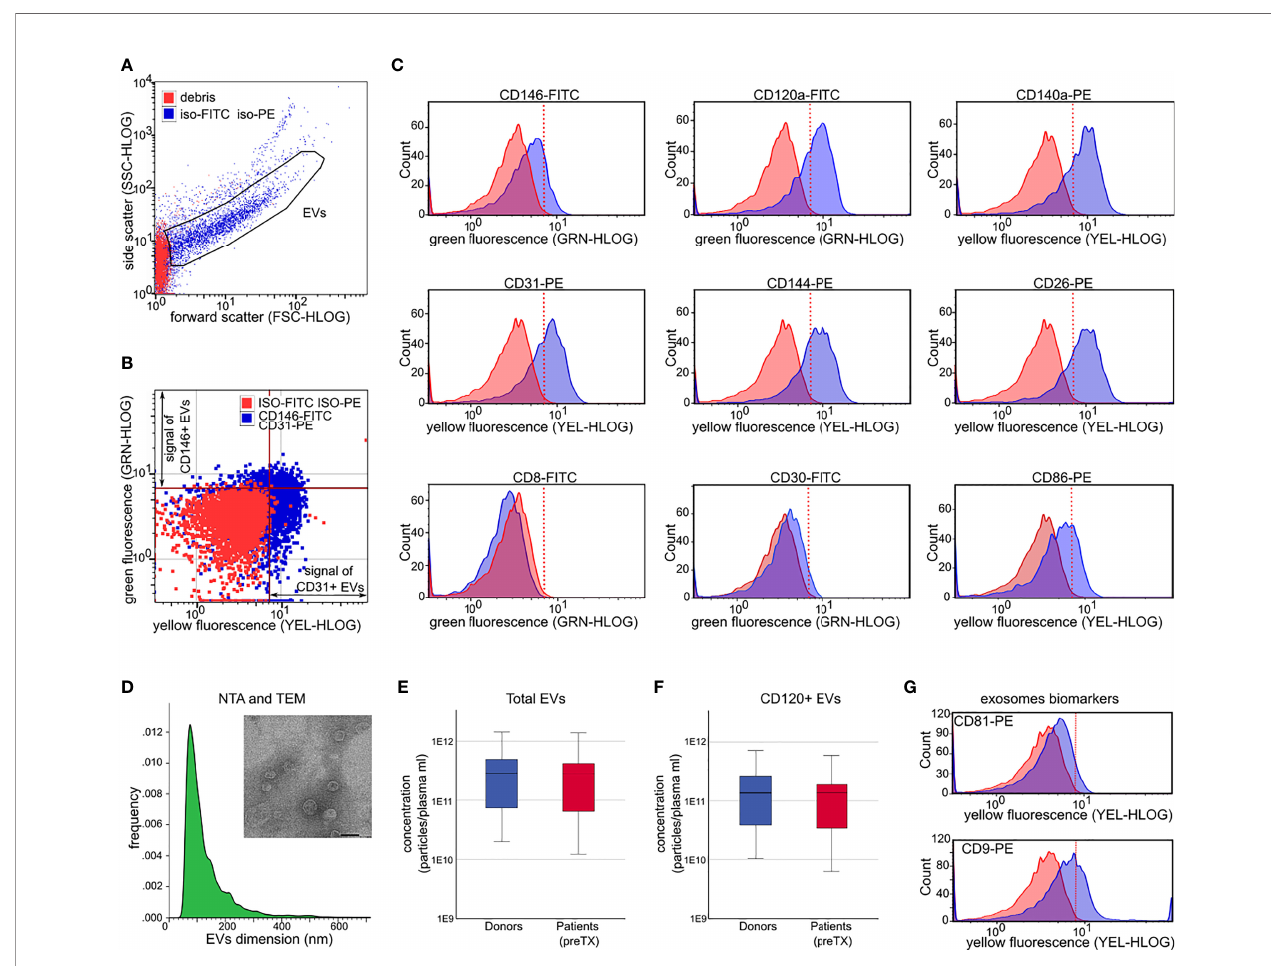
FIGURE 1 | Extracellular vesicle (EV) characterization by light scattering and fl uorescence. (A) Forward and side scatter dot plots of EVs analyzed after incubation with non-immune isotypic FITC and PE-IgG (iso-FITC/iso-PE, negative controls, blue dots). Red dots represent debris. (B) Representative fl uorescence dot plots showing EV fl uorescence after incubation with non-immune isotypic FITC and PE-IgG (negative controls, red dots), and after incubation with anti-CD146-FITC and anti-CD31-PE (blue dots). The red line marks the threshold to discriminate the positive FITC (green fl uorescence) and the positive PE fl uorescence (yellow fl uorescence) signal from the background. (C) Representative histograms showing the shift in fl uorescence after incubation of EVs with the indicated antibodies (blue peaks) with respect to isotypic control (FMO, red peaks). (D) Donor EV dimension histograms by nanoparticle tracking analysis. Inset: representative image of EVs detected by transmission electron microscopy (magni fi cation ×60,000; scale bar 50 nm). (E, F) Plasma concentration of total EVs (E) and concentration of CD120+ EVs (F) in donors (blue) and in patients prior to transplant (preTX, red). (G) Representative fl ow cytometry histograms showing the shift in fl uorescence after incubation of donor EVs with anti-CD9-PE and anti-CD81-PE (exosomes biomarkers). EVs = gated region; red line marks threshold to discriminate positive fl orescence signal from